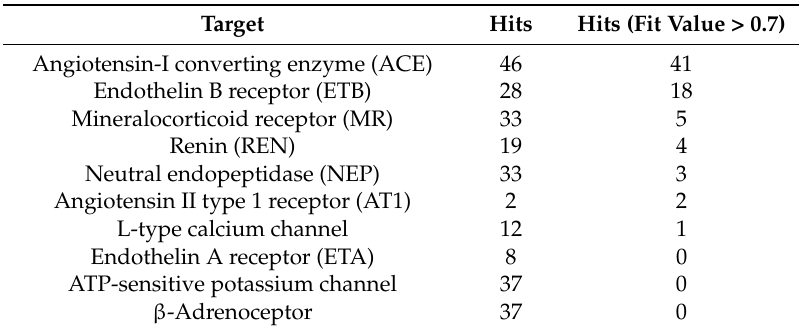
Table 2. Reverse target identification results of adlay